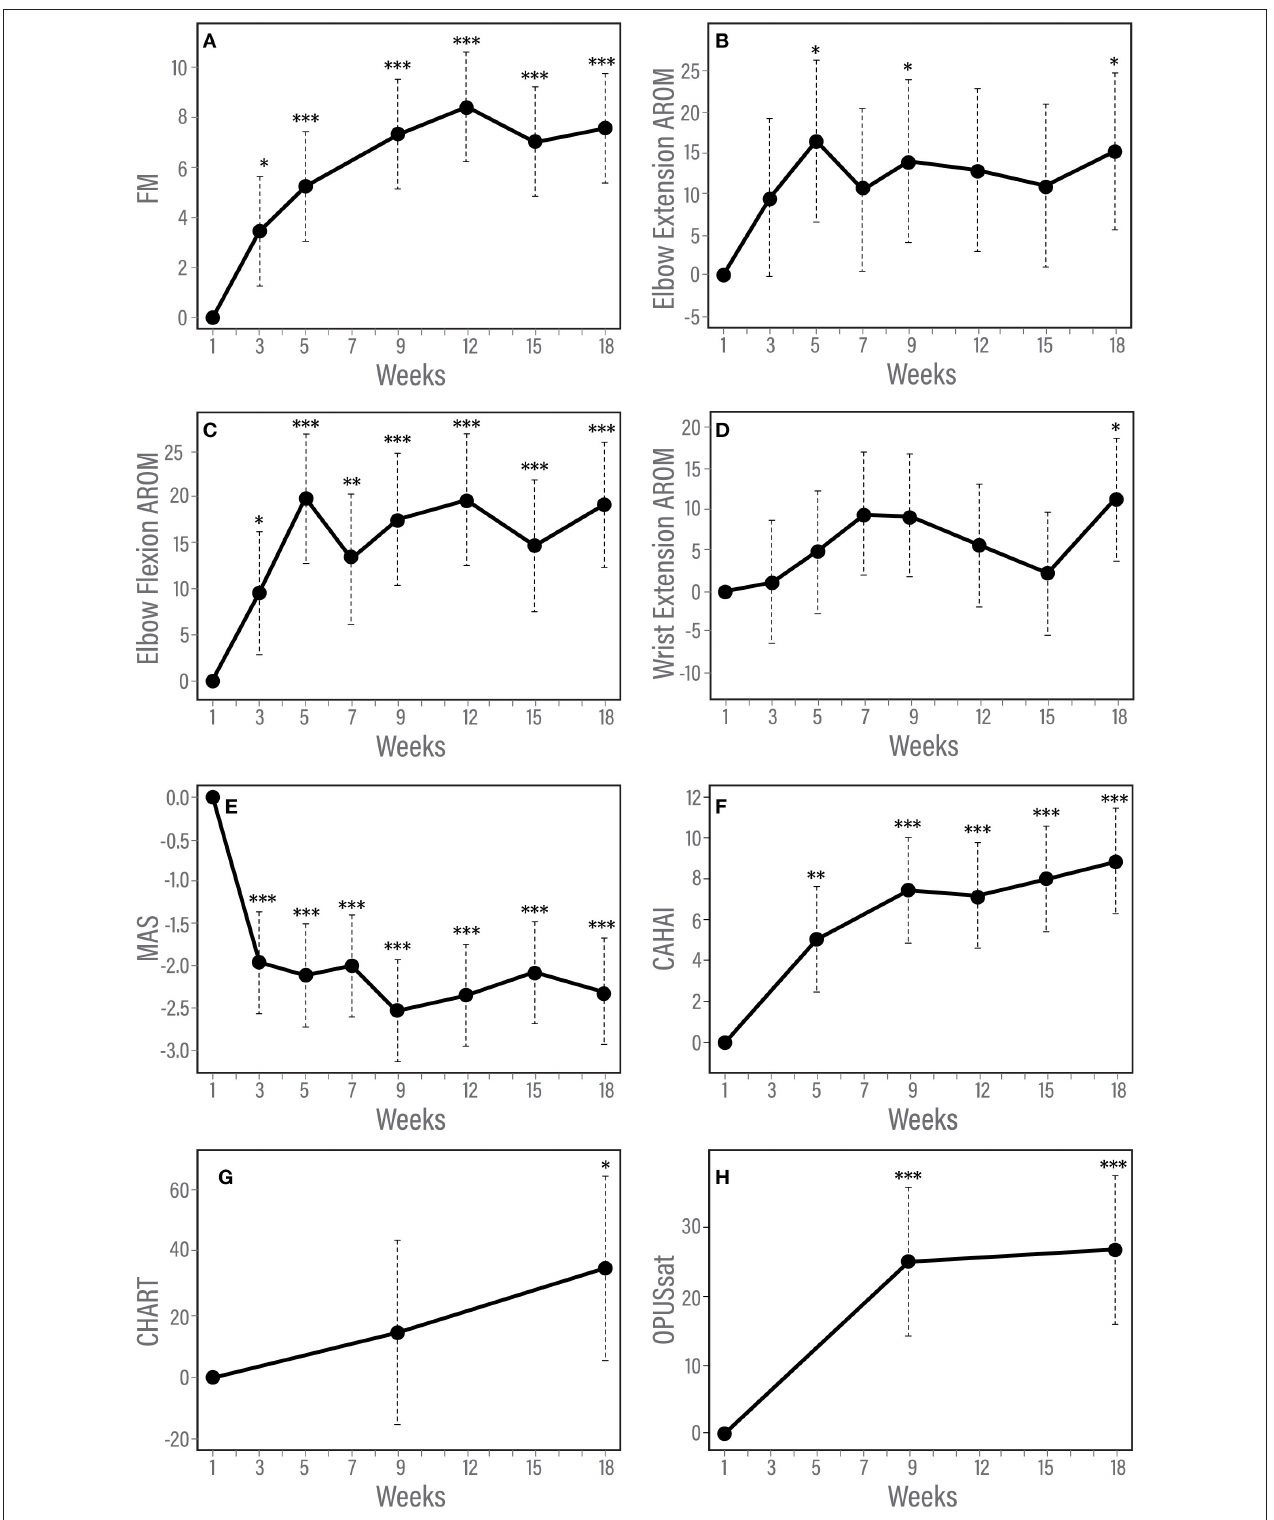
FIGURE 3 | (A–H) Trajectory of changes in response to therapy according to measures of impairment, function and satisfaction. Results of longitudinal linear mixed effects model adjusted for baseline score and injury type. (A) Fugl-Meyer for upper limb, (B) Modified Ashworth Scale, (C) Elbow flexion active range of motion, (D) Elbow extension active range of motion, (E) Chedoke Arm and Hand Activity Inventory, and (F) Orthotic and Prosthetic Users’s Survey satisfaction module. * p < 0.05; ** p < 0.01; *** p < 0.001.